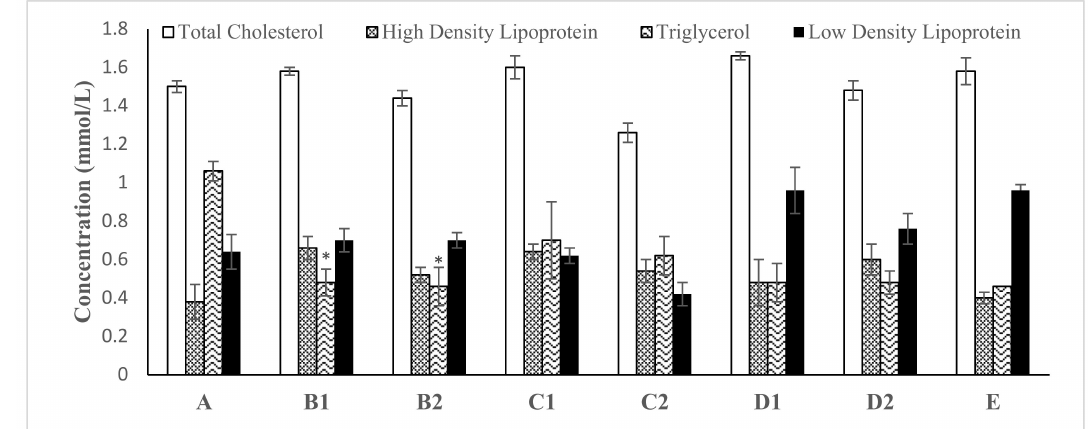
Figure 4. The effect of various concentrations of biosynthesized ZnO NPsAL on TC, HDL, TG, and LDL concentrations in rats. Data are presented as the mean ± SEM of at least n ≥ 5 replicate experiments and analyzed using one-way ANOVA followed by Newman–Keuls post hoc analysis. (*) p < 0.05; Abbreviations: A, Control; B1, 0.01 M ZnO NPsAL (80 mg kg − 1 ); B2, 0.01 M ZnO NPsAL (40 mg kg − 1 ); C1, 0.05 M ZnO NPsAL (80 mg kg − 1 ); C2, 0.05 M ZnO NPsAL (40 mg kg − 1 ); D1, 0.1 M ZnO NPsAL (80 mg kg − 1 ); D2, 0.1 M ZnO NPsAL (40 mg kg − 1 ); E, Zinc nitrate solution (80/40 mg kg − 1